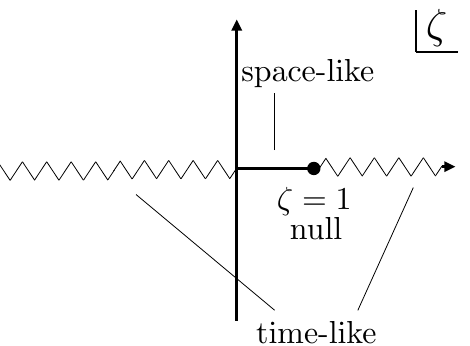
Figure 9 . The analytic structure of the bulk correlation function (6.6). There are two branch-cuts on the real axis with ζ > 1 and ζ < 0 , respectively. The branch-cut with ζ > 1 is introduced by the hypergeometric function and the branch-cut with ζ < 0 is introduced by ζ ∆ . Using 2 F 1 equation (6.5), we can show that region ζ > 1 or ζ < 0 , 0 < ζ < 1 , ζ = 1 correspond to time-like, space-like, null separated two points in the bulk,